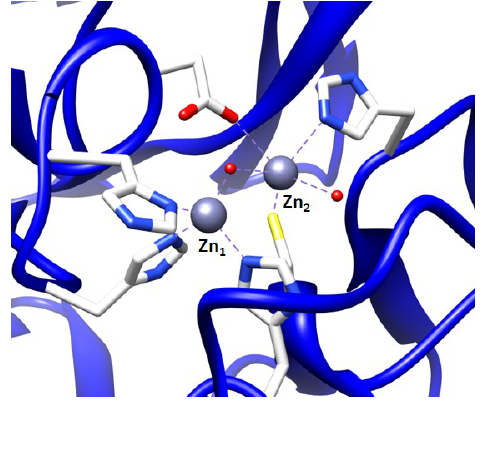
site of BcII is colored in